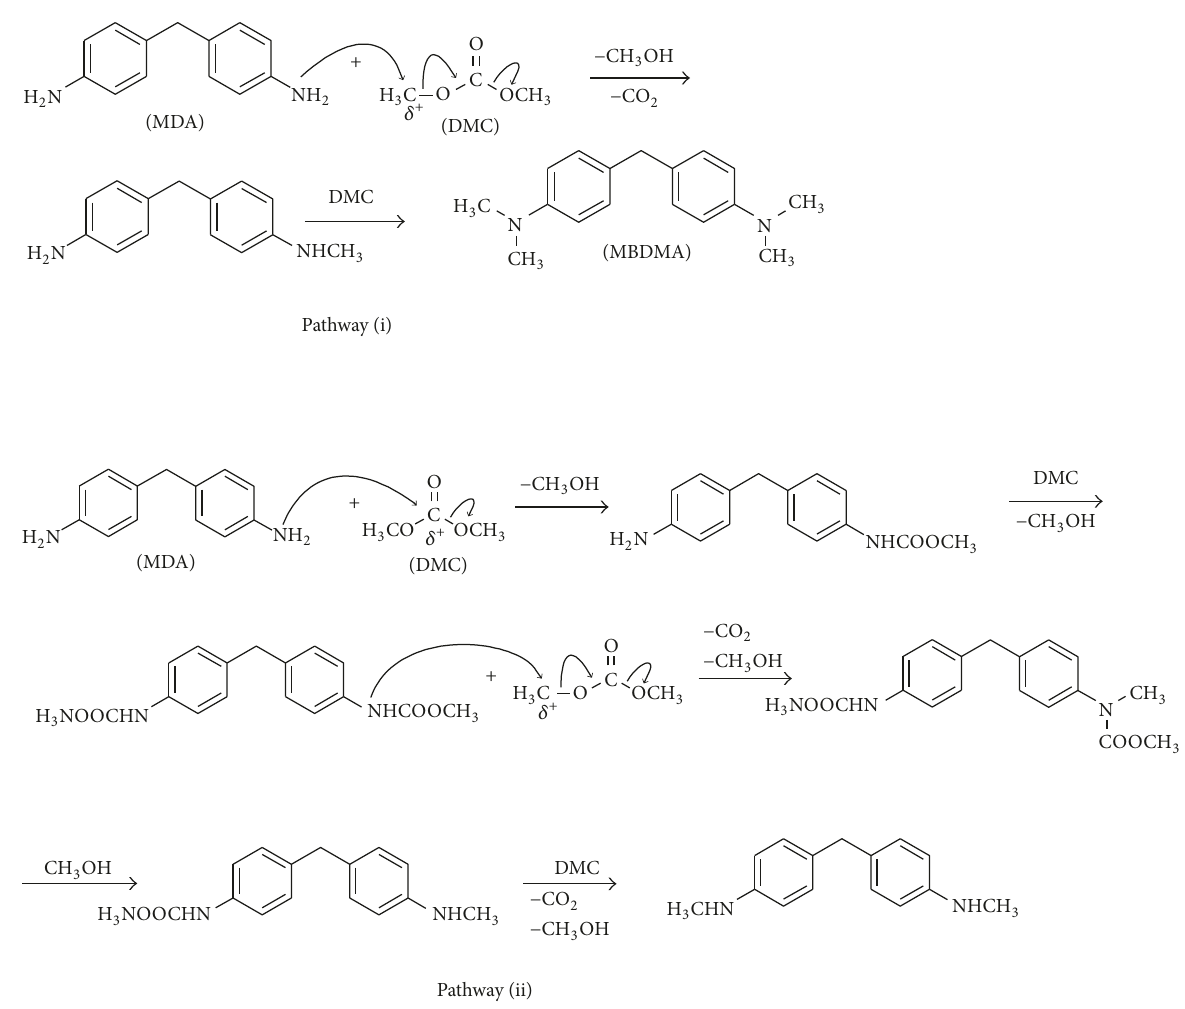
Scheme 2: Two possible pathways of the N-methylation process of MDA with DMC in the presence of